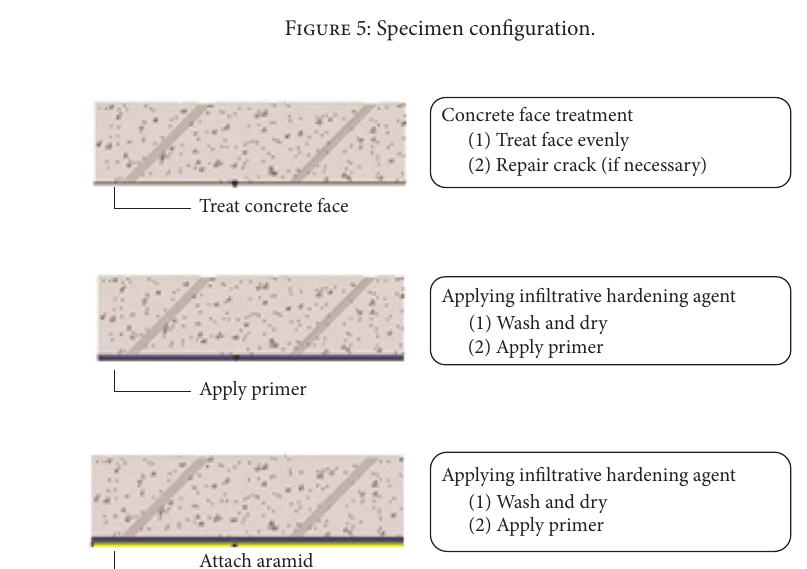
Figure 5: Specimen configuration.